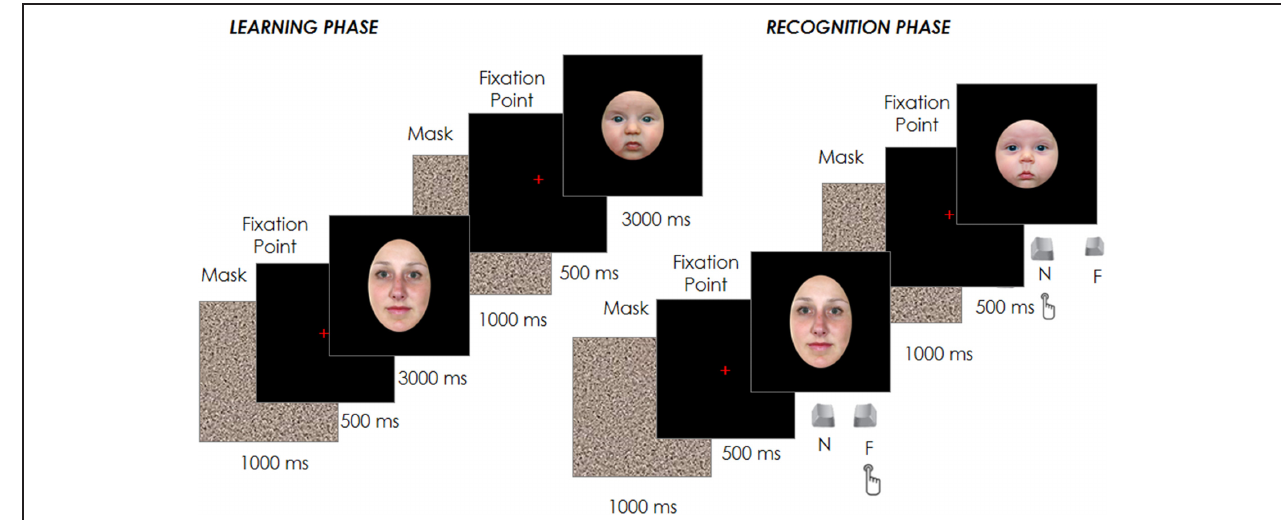
FIGURE 1 | Schematic representation of the experimental